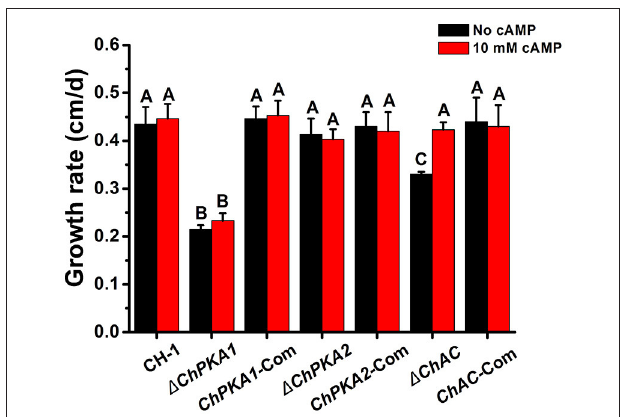
FIGURE 3 | Growth rate of indicated strains. Growth rate of indicated strains cultured on PDA medium with (red) or without (black) exogenous 10 mM cAMP at 25 ◦ C. Bars represent standard deviations of three replications. Different letters in the graph indicate statistical differences, P ≤ 0.01.